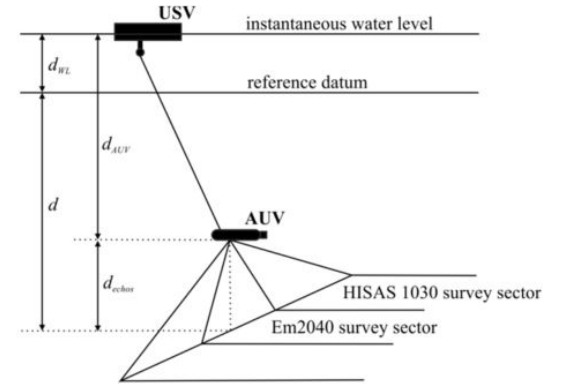
Figure 14. Basic scheme for AUV-acquired depth estimation (based on